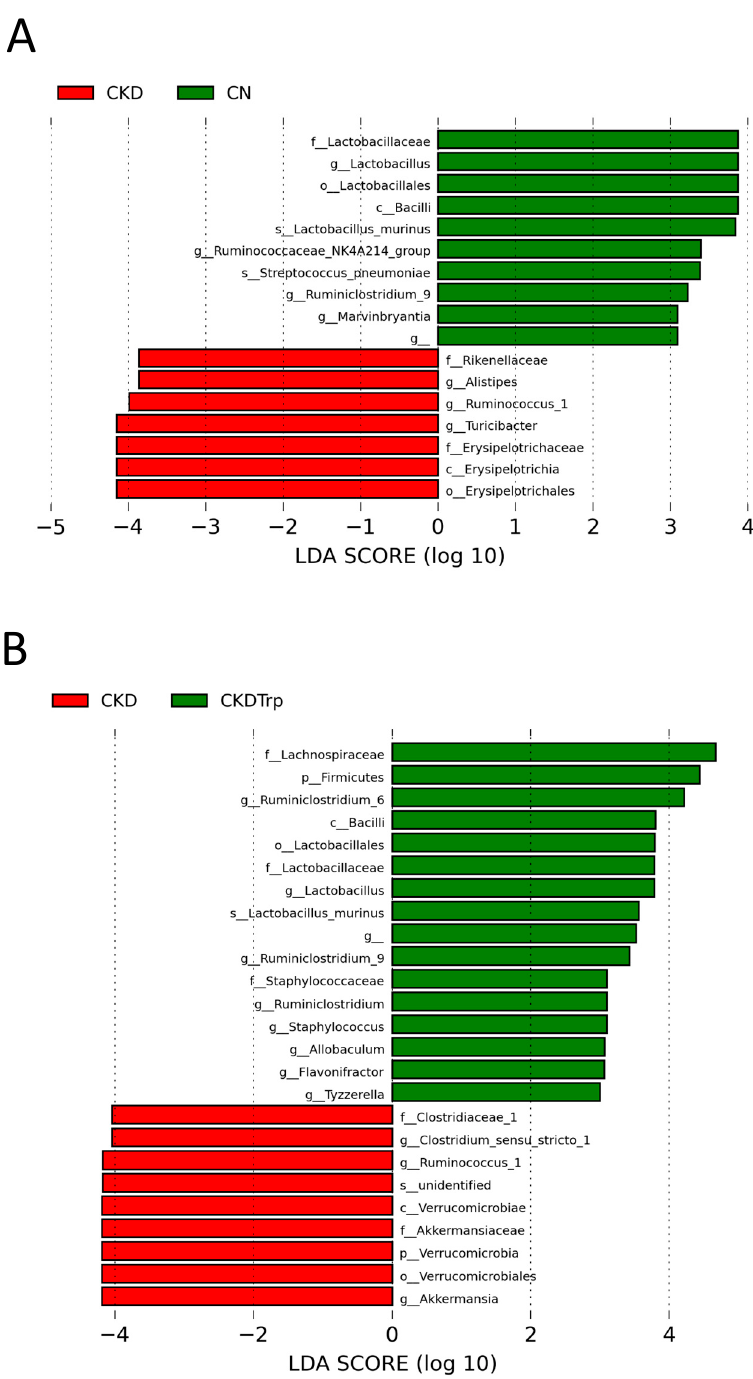
Effect of maternal adenine-induced chronic kidney disease (CKD) and tryptophan supplementation (Trp) on the gut microbiota at 12 weeks of age. Linear discriminant analysis effect size (LEfSe) was applied to identify enriched bacterial species. The threshold of the linear discriminant was set to 3. Most enriched and depleted species in the ( A ) CKD (red) versus CN group (green) and ( B ) CKD (red) versus CKDTrp group (green).